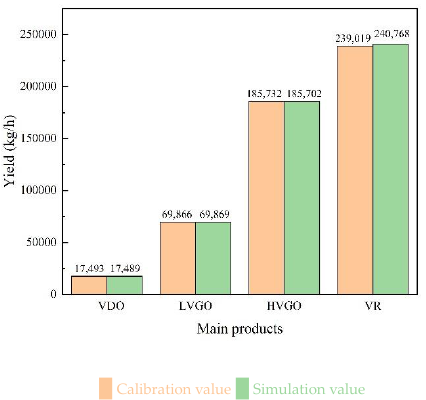
Figure 8. Comparison of main product yields of rigorous model.